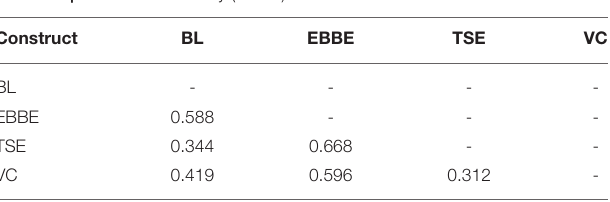
TABLE 3 | Discriminant validity (HTMT). TABLE 4 | Direct, indirect, and total path